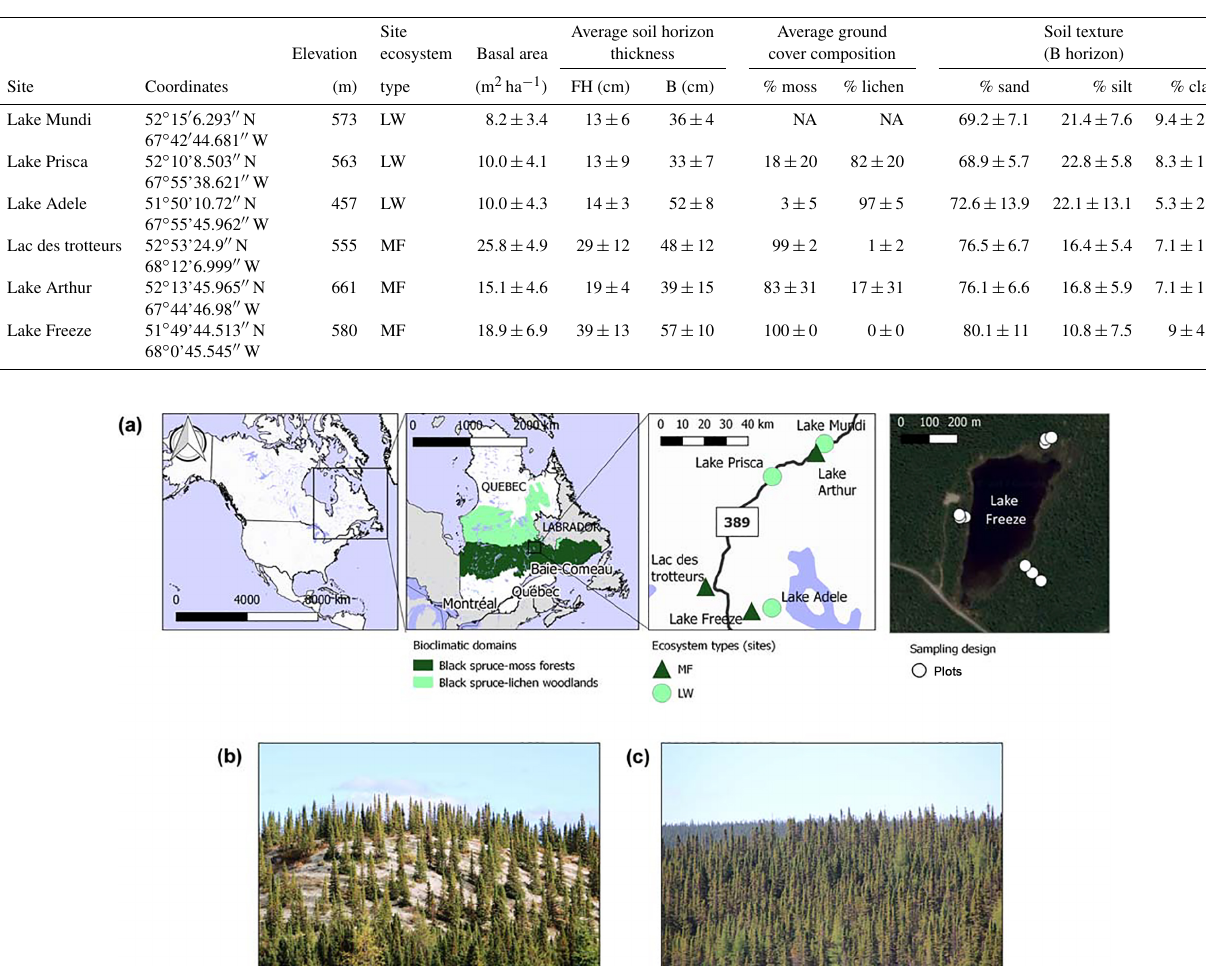
Figure 1. Overview of the study area and sites. (a) Geographical localisation of the study area and distribution of the study sites (experimental units). The study area is located in Quebec, Canada, at a latitude of 52 ◦ N and a longitude of 67–68 ◦ W. The right panel presents the sampling design as undertaken in each EU around the watershed lake with three transects and three sampled distances (plots) by transect using a basemap from google maps openlayers. (b) Open black spruce–lichen woodland. (c) Closed black spruce–moss